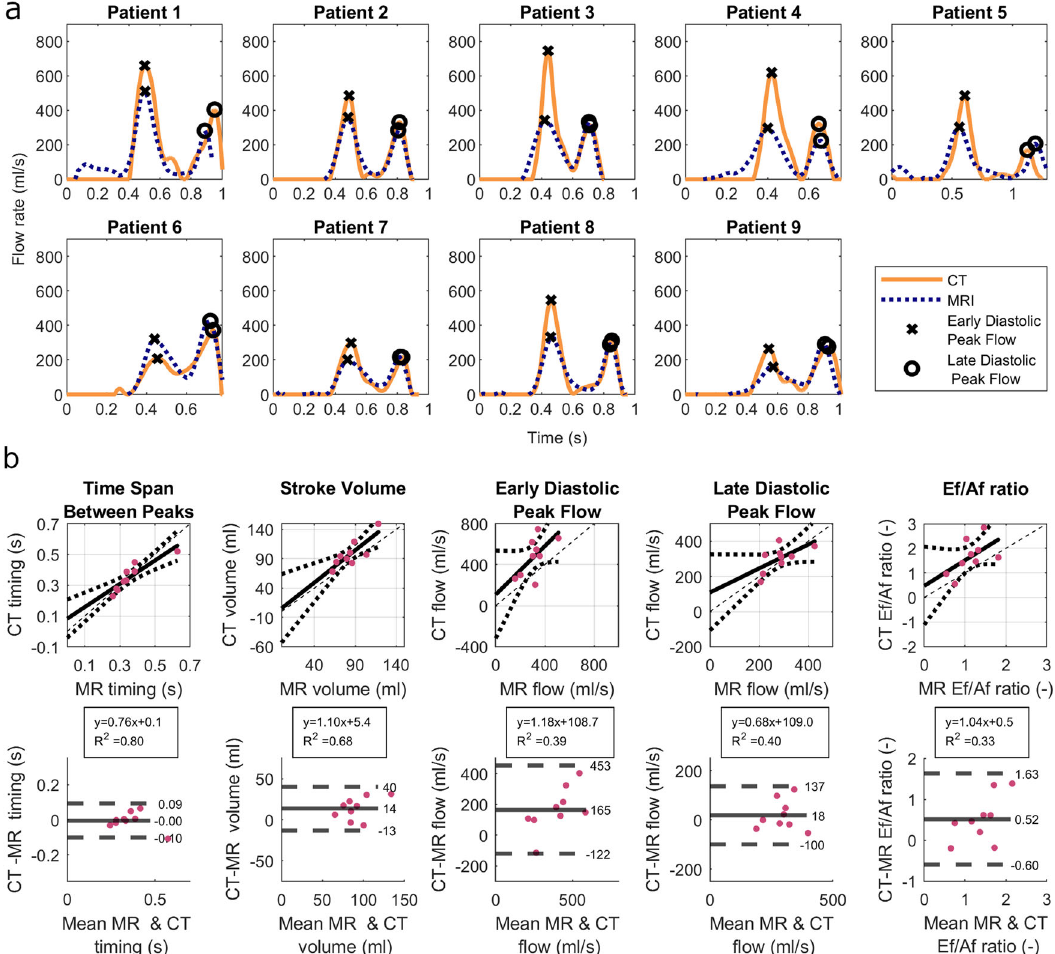
Fig. 3 Mitral Valve Flow. a Flow thought Mitral Valve calculated based on 4D fl ow MRI and time resolved CT, Early Diastolic Peak Flow is marked with x, and Late Diastolic Peak Flow is marked with o. b Comparison of MV fl ow parameters: Time Span Between Peaks, Ventricular Stroke Volume, Early Diastolic Peak Flow, Late Diastolic Peak Flow, and Ef/Af ratio in 4D fl ow MRI and 4D CT. Top: Solid line indicates Linear Regression line; Dotted lines indicate 95% con fi dence bounds; Dashed line indicates identity line. The box shows the linear regression equation and the coef fi cient of determination R 2 . Bottom: Bland-Altman Plot; Solid line indicates the bias, Dashed lines indicate ±1.96 standard